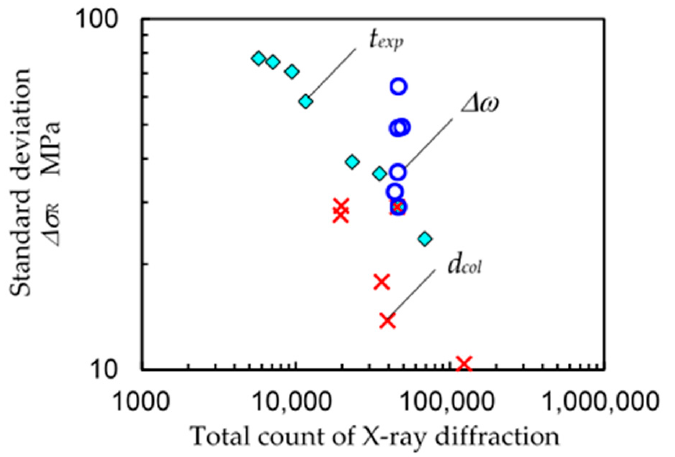
Figure 10. Typical X-ray diffraction patterns detected by 2D-PSPC at ψ = 0° and φ = 0° from stainless steel treated by cavitation peening (Specimen A). ( a ) effect of the collimator diameter d col at ∆ ω = 8°; ( b ) effect of exposure time t exp at d col = 0.146 mm and ∆ ω = 8°; ( c ) effect of the ω -oscillation angle ∆ ω at d col = 0.146 mm and t exp = 20 min.